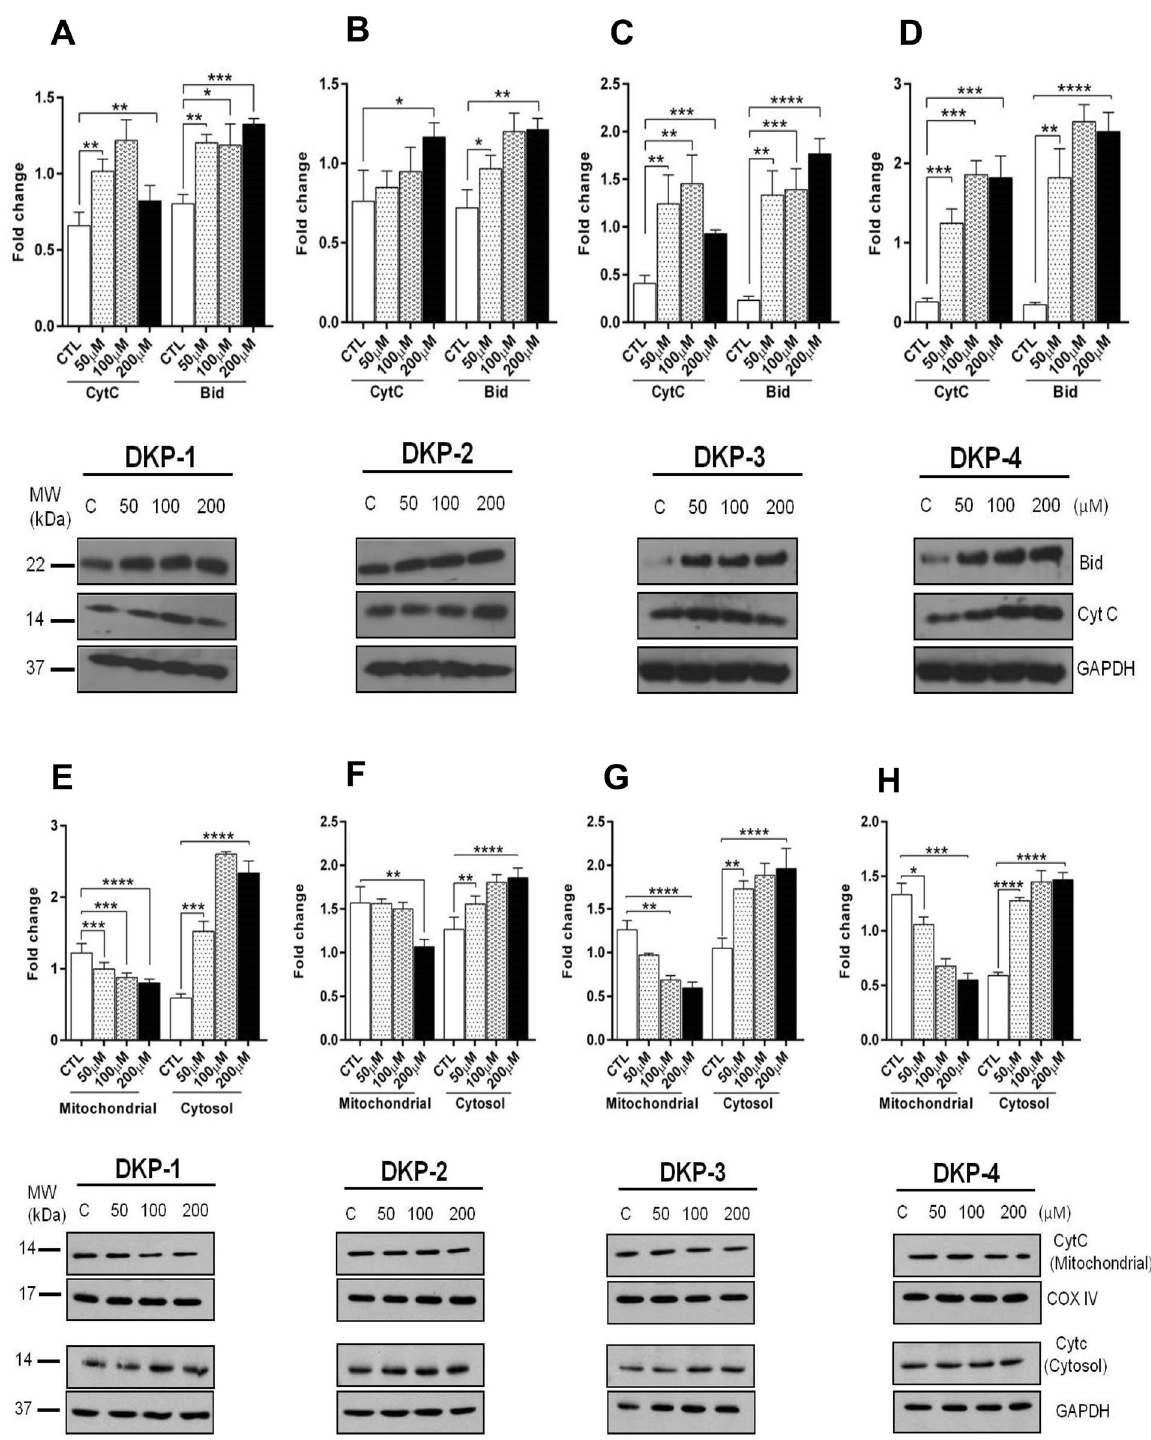
Figure 5. Apoptotic protein expression levels in DKPs treated and un-treated HT-29 cells for 24 h. ( A – D ) Effect of DKPs on the expression of apoptosis-related proteins in the whole-cell lysate of DKP-1: cyclo (l-Pro-l-Leu) ( A ), DKP-2: cyclo (l-Pro-l-Val) ( B ), DKP-3: cyclo (l-Pro-l-Phe) ( C ), and DKP-4: cyclo (l-Pro-l-Tyr) ( D ) for 24 h. ( E–H ) Effect of DKPs on the cytochrome-c levels from the mitochondrial and cytosolic fraction of DKP-1: cyclo (l-Pro-l-Leu) ( E ), DKP-2: cyclo (l-Pro-l-Val) ( F ), DKP-3: cyclo (l-Pro-l-Phe) ( G ), and DKP-4: cyclo (l-Pro-l-Tyr) ( H ). Western blot analysis was performed using antibodies against CytC, Bid, and GADH served as a housing gene. Data were presented as the mean ± SD (n = 3). Data were analyzed by one-way ANOVA with student’s two-tailed t -test. The asterisks * p < 0.05, ** p < 0.001, *** p < 0.0001, **** p < 0.0001, indicates a significant difference between the control in response to DKPs treaments. The groupings were cropped from different gels subjected to identical conditions. Full blots were shown in the Supplementary Information, Fig.